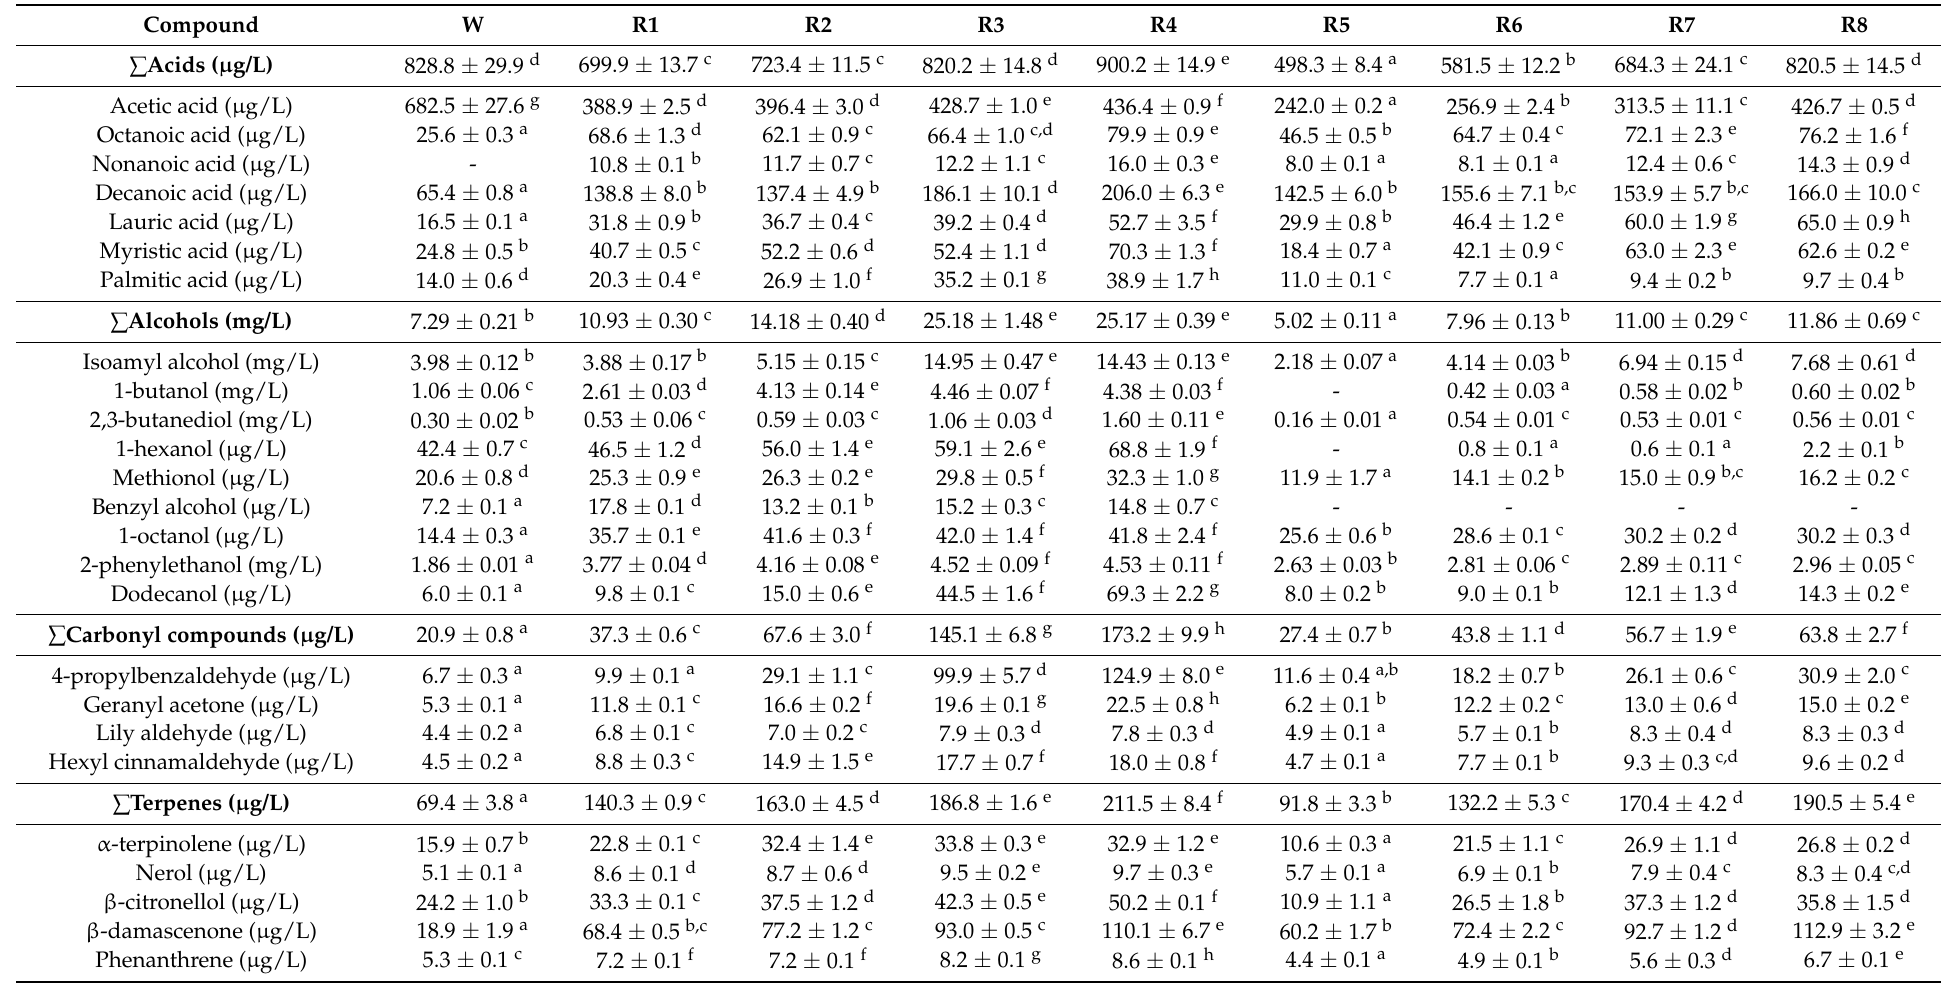
Table 4. Aroma compounds identified in Cabernet Sauvignon red wine and reverse osmosis retentates at 2.5, 3.5, 4.5 and 5.5 MPa with cooling and without cooling.